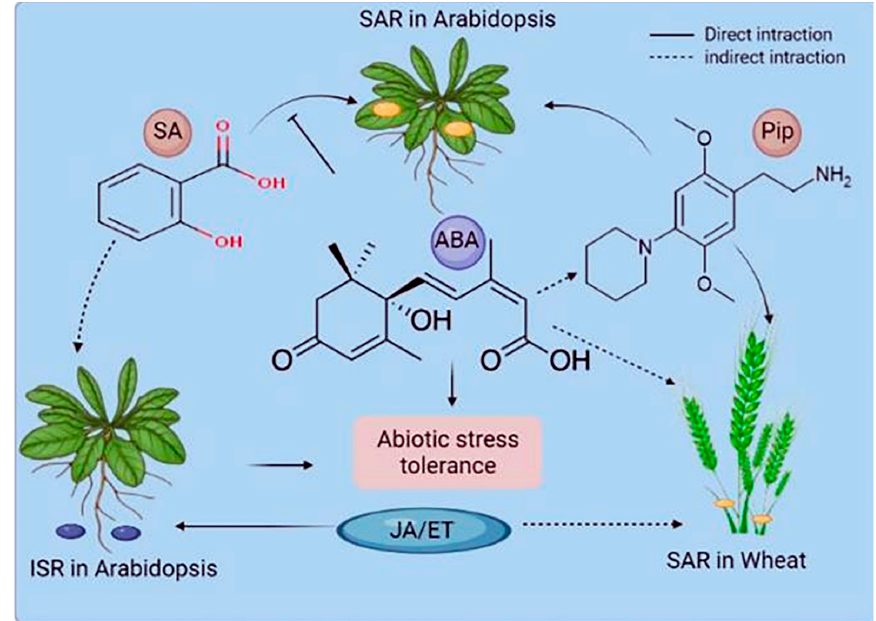
Figure 3. Phytohormones’ role in systemic acquired resistance (SAR) and induced systemic re- sistance (ISR). The interactions of stress-associated phytohormones vary based on the systemic re- sistance mechanism and the plant species. Hormones can directly function in signaling or pathway antagonism or have an indirect or undefined role. ABA denotes abscisic acid, JA denotes jasmonic acid, ET denotes ethylene, and Pip denotes pipecolic acid.